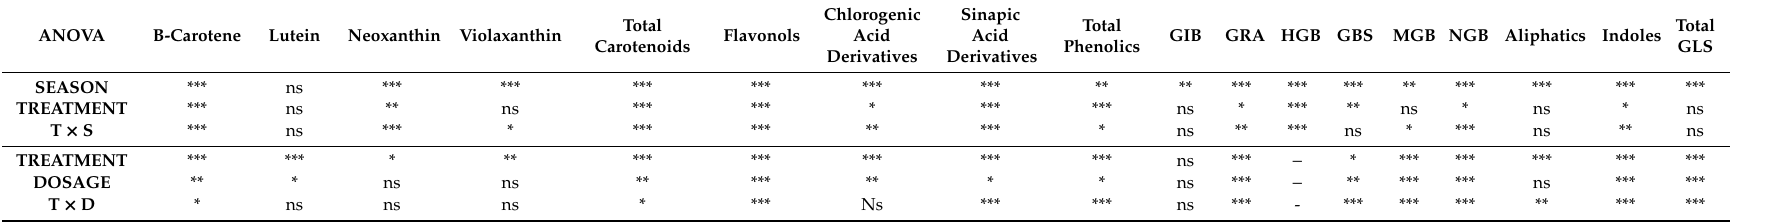
Table 3. Results of two-way ANOVA of carotenoids, phenolic compounds and glucosinolates (GIB: glucoiberin (3-methylsulfinylpropyl-gls), GRA: glucoraphanin (4-Methylsulphinylbutyl-gls), HGB: hydroxyglucobrassicin (4-Hydroxy-3-indolylmethyl-gls), GBS: glucobrassicin (3-Indolylmethyl-gls), MGB: